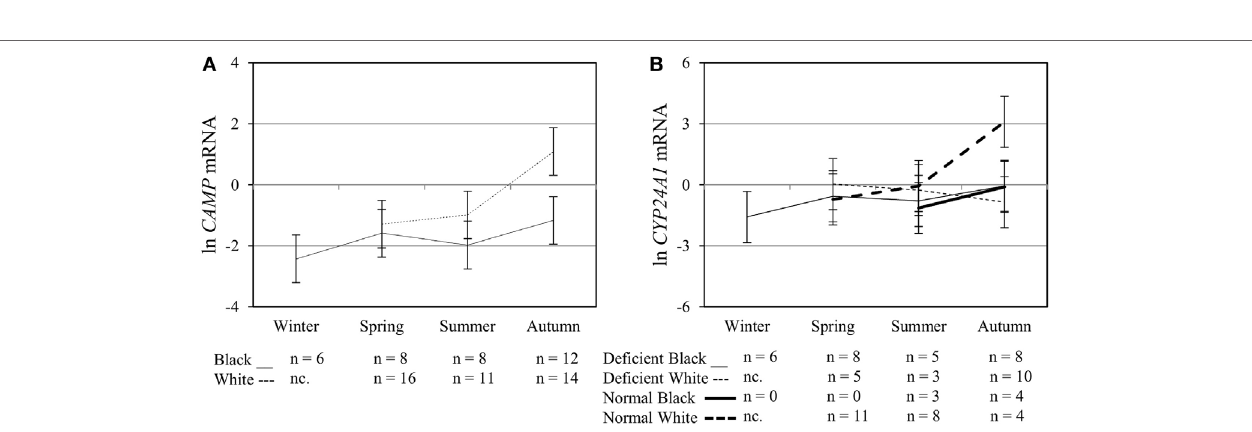
FigUre 5 | Interaction between season, race, and 25(OH)D 3 status influence vitamin D receptor (VDR) transactivation of cathelicidin antimicrobial peptide ( CAMP ) and 25-hydroxyvitamin D 3 -24-hydroxylase ( CYP24A1 ). The line graphs show the interaction effects for CAMP mRNA (a) and CYP24A1 mRNA (B) level, quantified by RT-qPCR, in monocytes/macrophages from healthy Black ( n = 34) and White ( n = 41) South Africans. Season and race interacted significantly to influence CAMP mRNA ( P < 0.050), while season, race, and 25(OH)D 3 status showed interaction effects on CYP24A1 mRNA levels ( P < 0.050). Error bars show the least significant difference at P < 0.050. nc. = not collected.